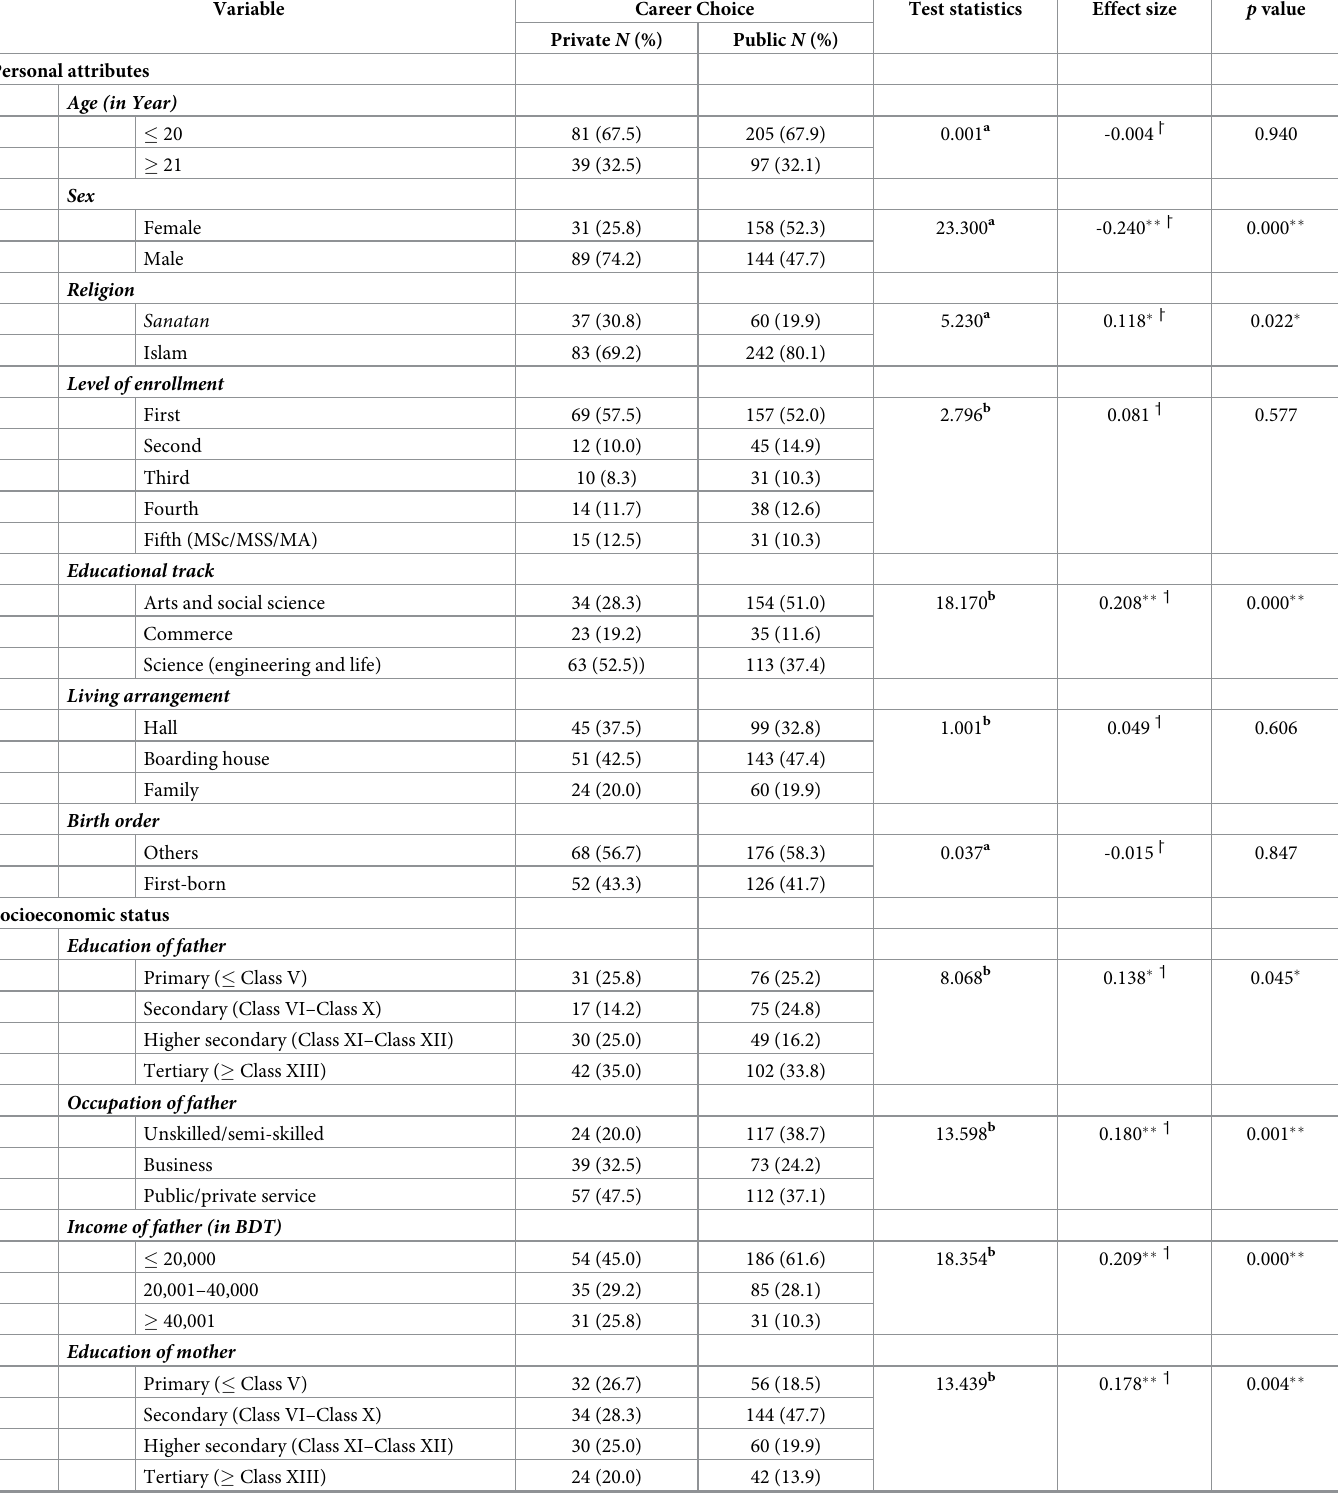
Table 1. Career choices based on personal and family